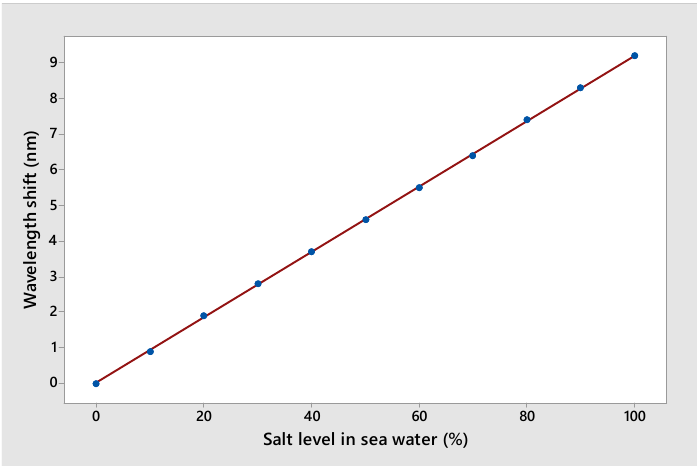
Figure 7. Peak wavelength shift as function of salt level for a deformed photonic structure with 50 alternated layers of fused silica and TiO 2 and with a middle cavity filled with seawater at room temperature.